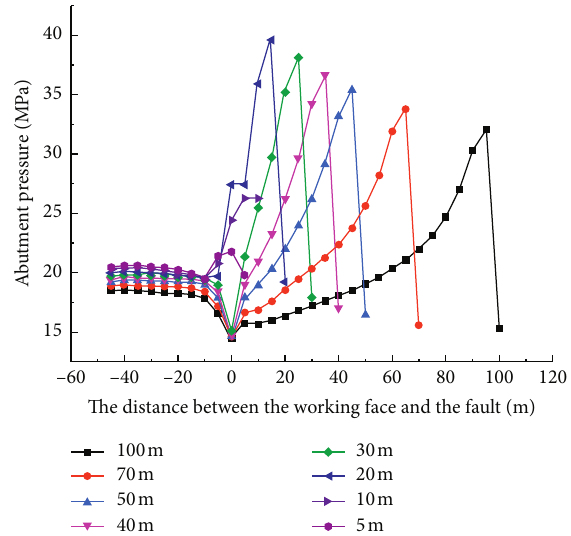
Figure 12: Distribution characteristics of the abutment pressure in footwall face fault